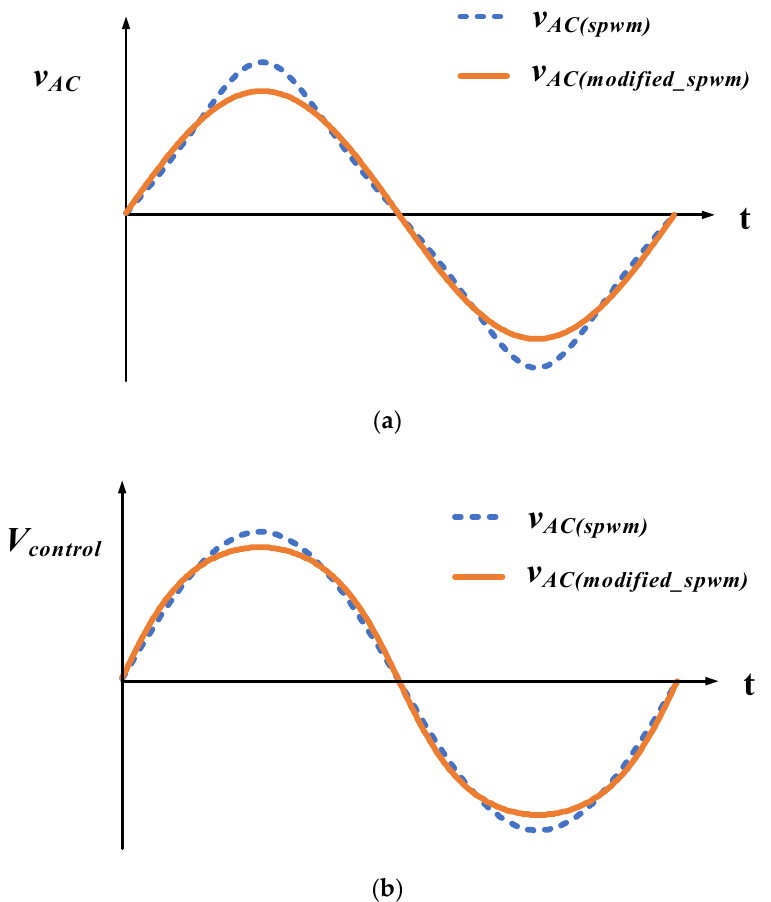
Figure 10. A comparison between the traditional SPWM control and the modified SPWM control: ( a ) V control and ( b ) v AC .